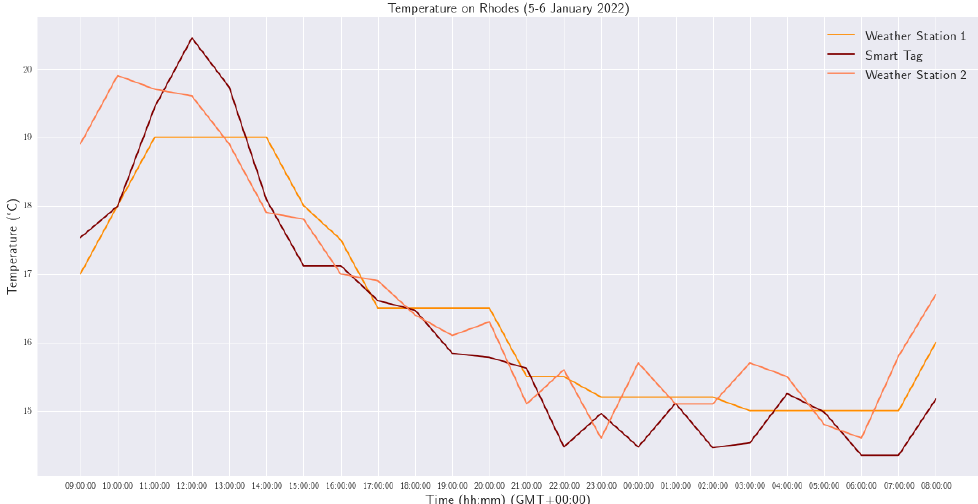
Figure 14. Temperature on Rhodes measured by a Smart Tag and two commercial weather stations.